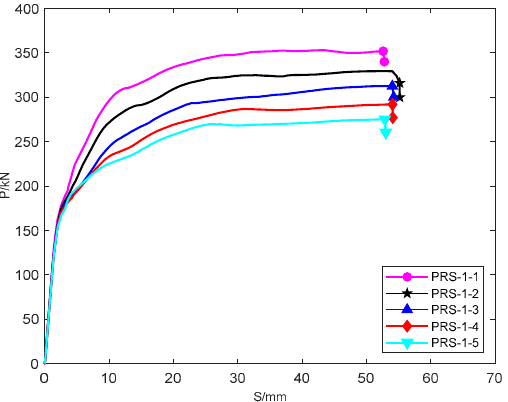
Figure 12. Effect of non-prestressed reinforcement on mid span deflection. The ultimate bending moment of the PRS increased continuously with the increase of the non-prestressed reinforcement ratio. Its increase shows a process of increasing and then decreasing with the increase of the non-prestressed reinforcement ratio. There is an optimal non-prestressed reinforcement ratio. For the PRS with the 0.27% prestressed steel strand, the prestressed degree is 0.61 at 0.64%, and a non-prestressed reinforcement ratio has the best performance. It means the model PRS-1-2 has the best bending resistance.